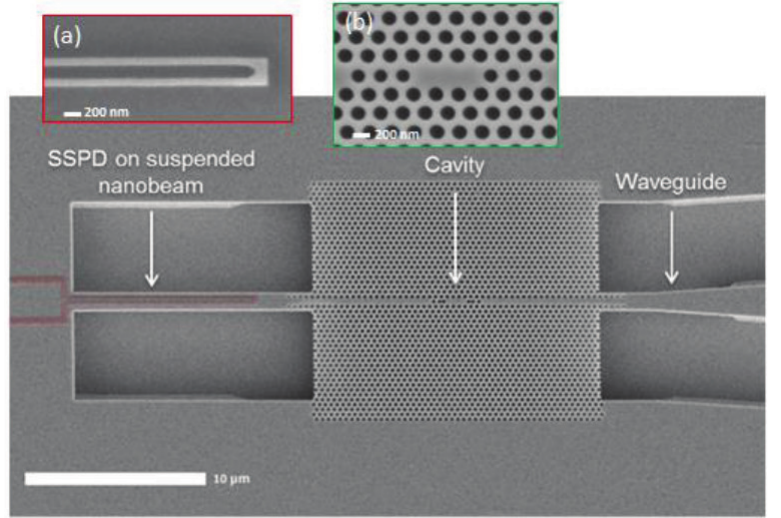
Figure 18. SEM image of a fully integrated single-photon source and detector. ( a ) Superconducting single-photon detector (SSPD), ( b ) photonic crystal cavity. The figure is reprinted with permissions from